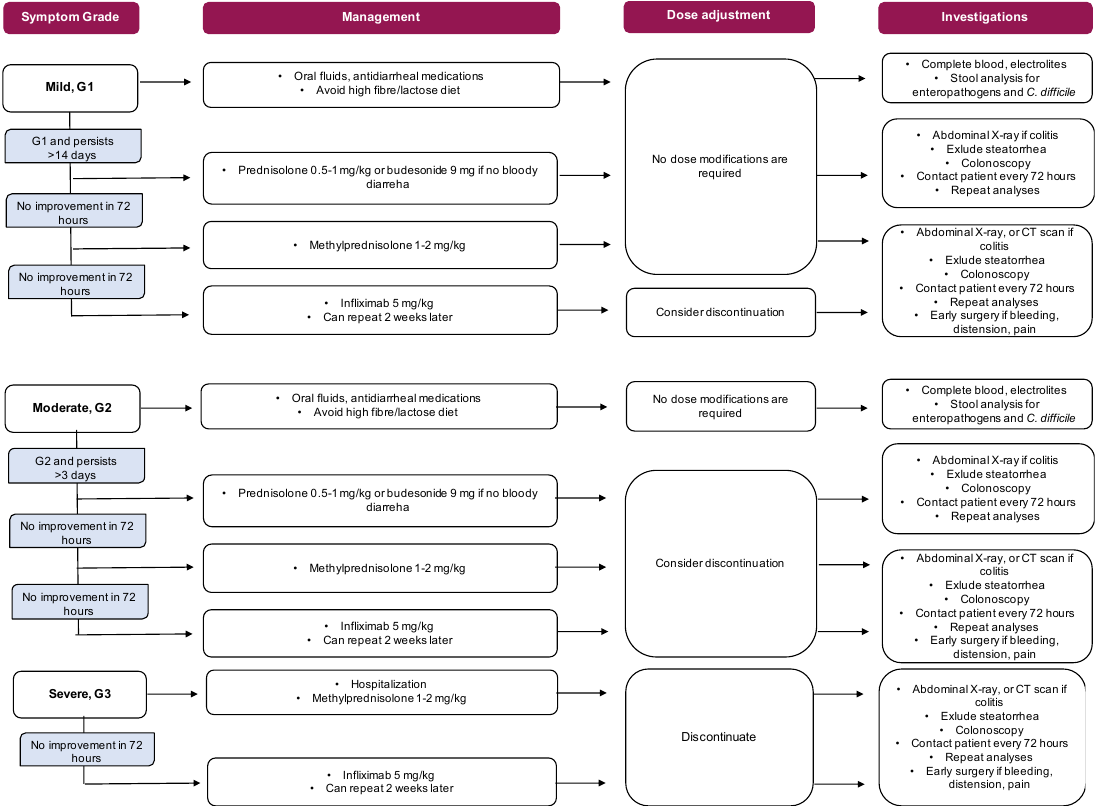
Figure 4. Dose modifications and management of immunotherapy.